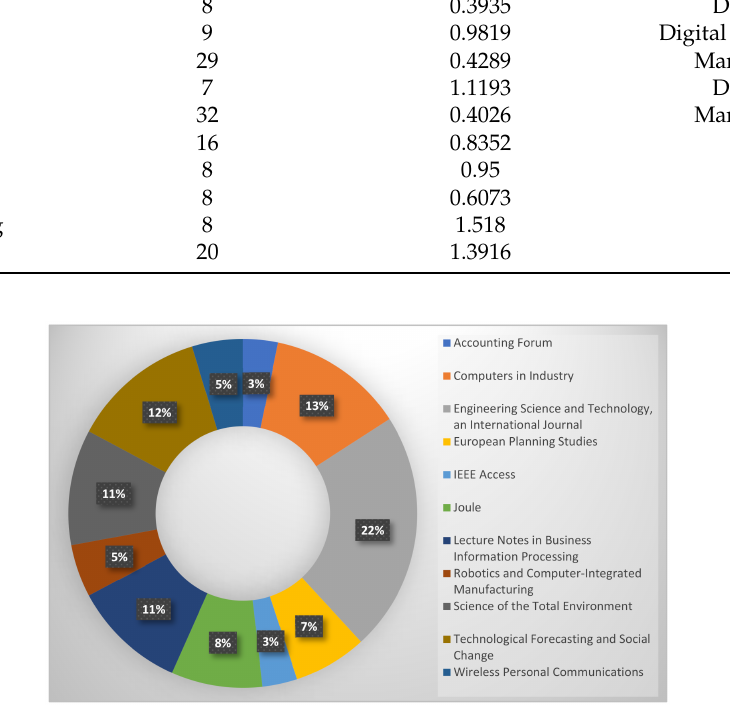
Figure 3. Distribution of citations from the journal source.